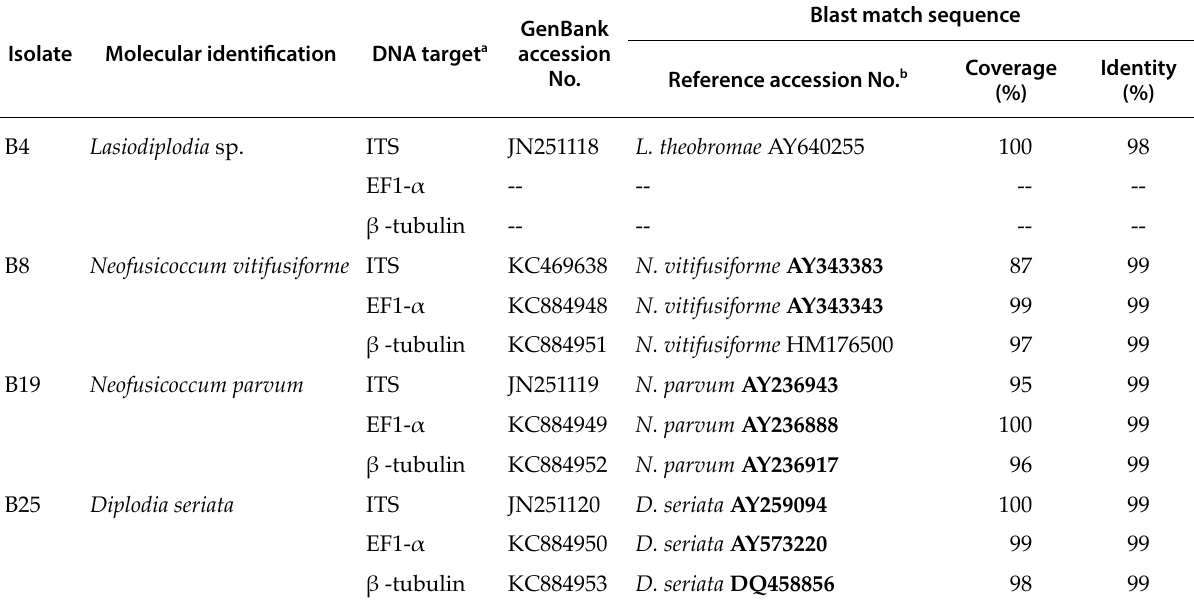
Table 3. Molecular identification and GenBank accession numbers of the representative isolates of the Botryosphaeriaceae species isolated in this study.